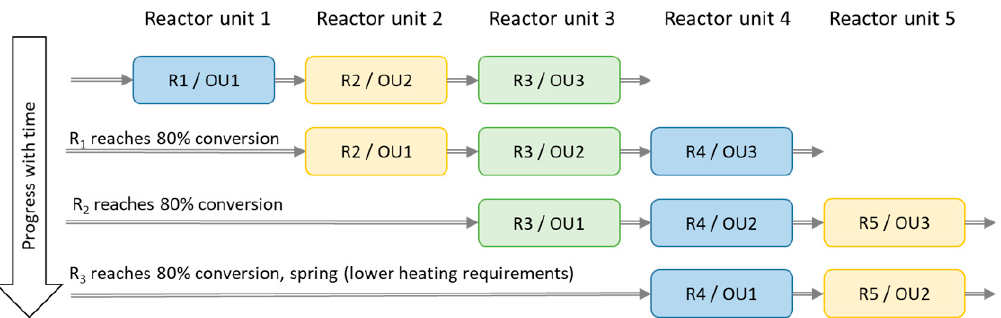
Figure 8. Schematic graph over reactor unit (R) 1–5 acting as operating unit (OU) 1–3. The physical divisions of the reactor are named R 1–5, while the OU 1–3 are reactors operating in chronological order.